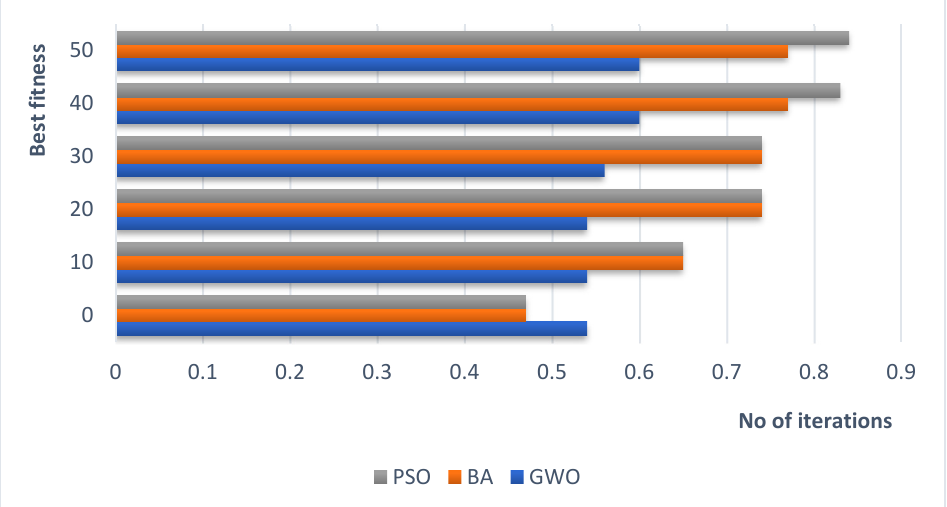
Figure 8. Comparison between the performance of GWO, BA, and PSO.